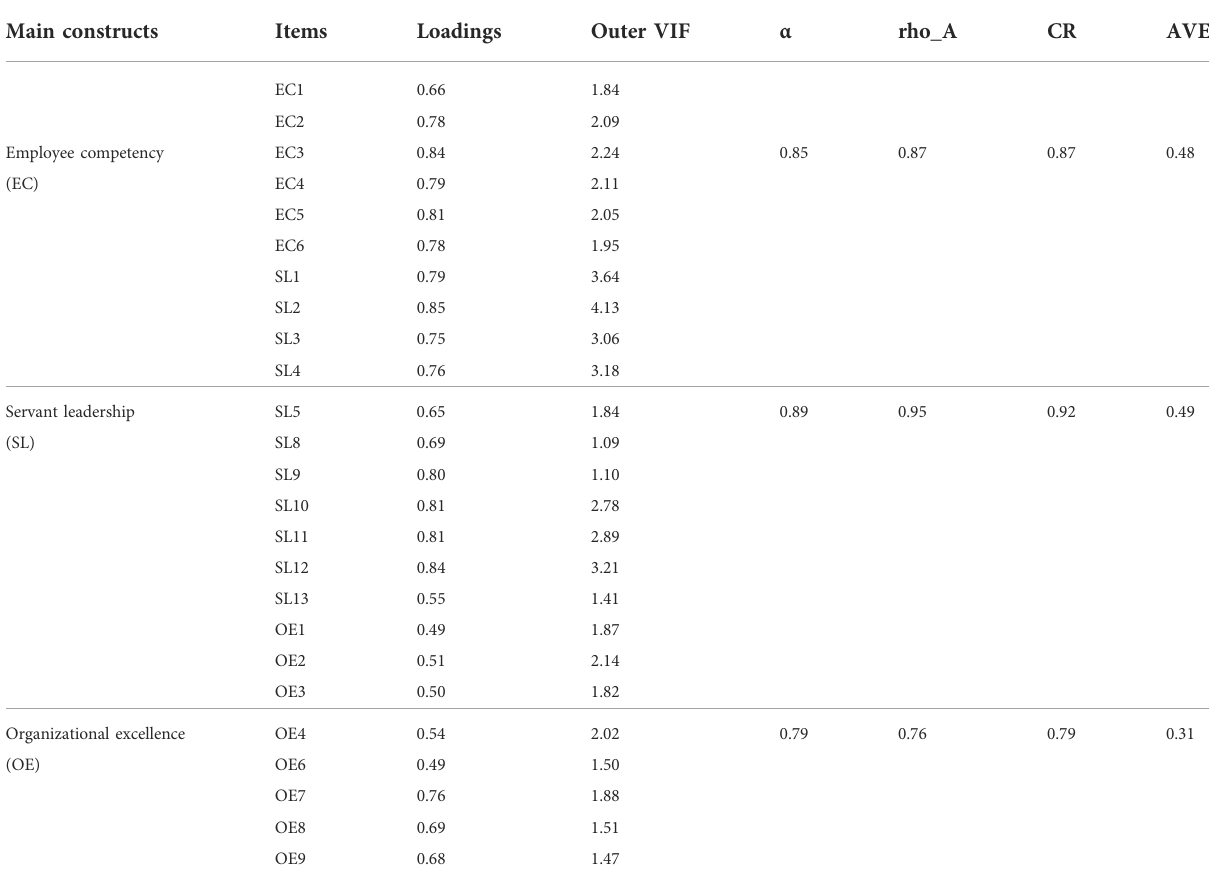
TABLE 2 Construct reliability, validity, and multi-collinearity.